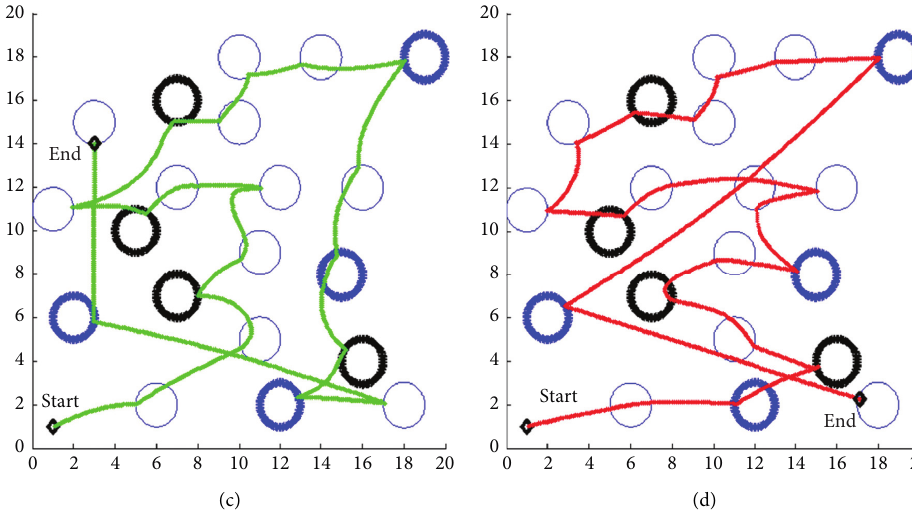
Figure 6: For different central field intensities, the trajectories for PS and PDS under the sources with different field intensity distributions. The correspondences are the blue circle- λ � 1, color-emphasized blue circle- λ � 1.5, and color-emphasized black circle- λ � 1.2. (a) The trajectory for PS under the sources with Gaussian-like shape field intensity distribution. (b) The trajectory for PDS under the sources with Gaussian-like shape field intensity distribution. (c) The trajectory for PS under the light sources. (d) The trajectory for PDS under the light sources.